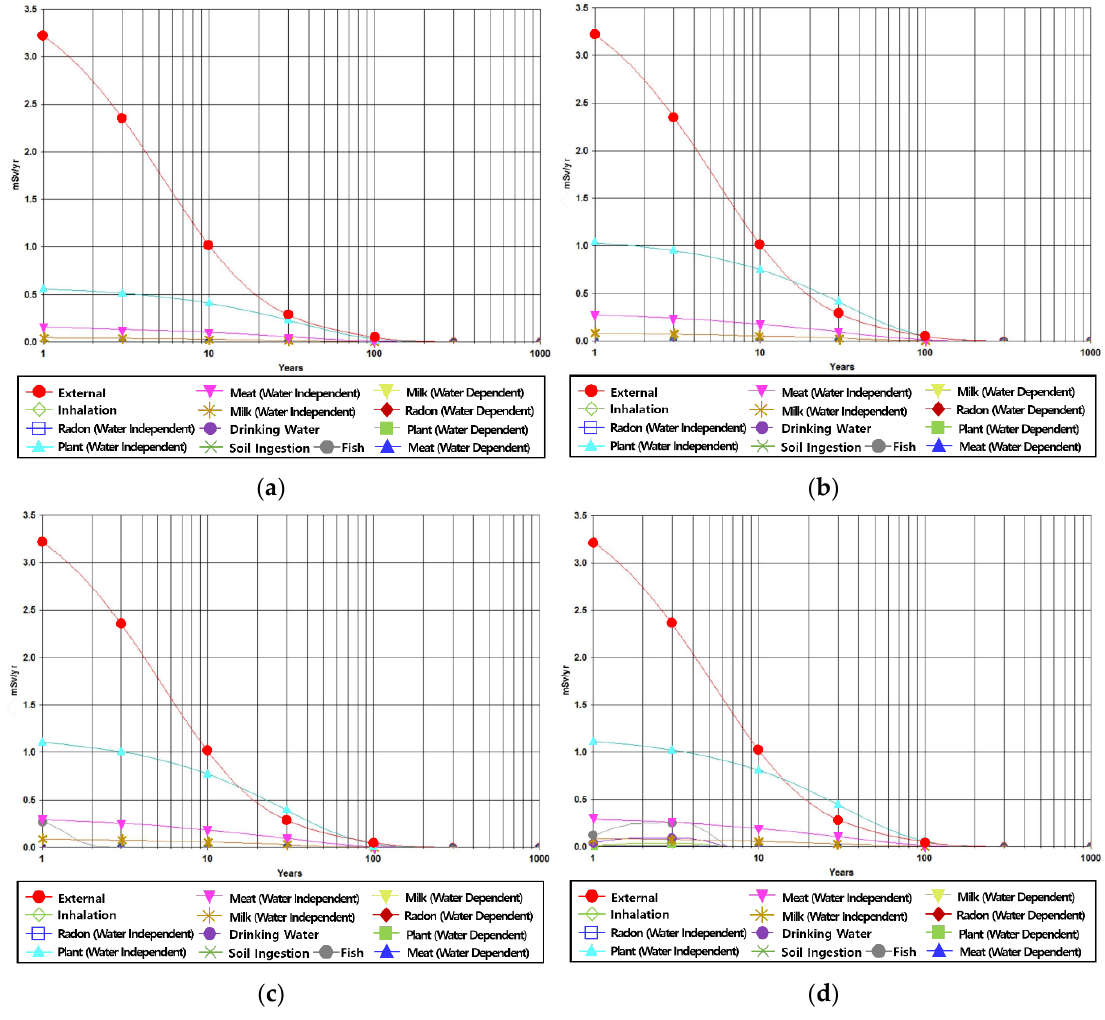
Figure 4. Dose graph by exposure pathway according to value: ( a ) upper value, ( b ) median value, ( c ) lower value, and ( d ) default value.